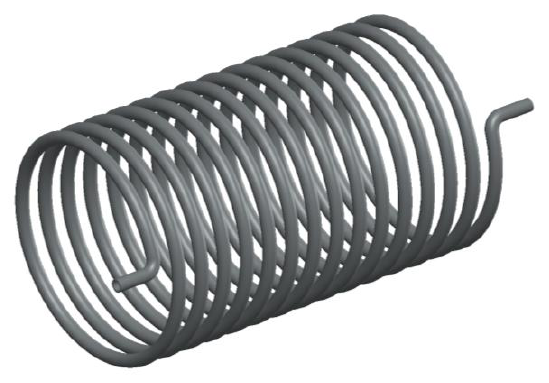
Figure 4. Helically coiled tubular reactor ( CT6